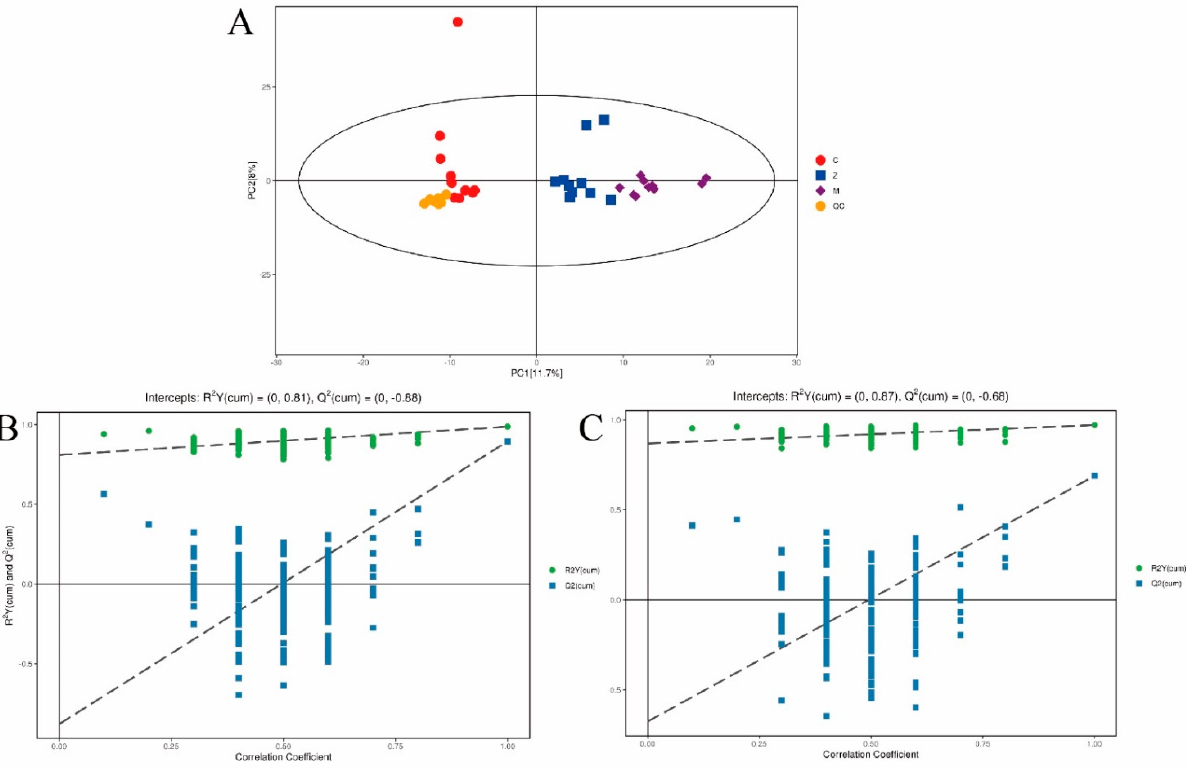
Figure 7. Score scatter plot for PCA model total with QC (Quality control). Global map of liver metabolites performed on a gas chromatography/mass spectrometry metabonomic platform. ( A ) Score scatter plot of the PCA model total with QC. Permutation test of orthogonal projections of latent structures discriminant analysis model for ( B ) group M vs. C and ( C ) group Z vs. M. C: Control group, M: high − fat diet group, and Z: MORPS − 1 group ( n = 10).